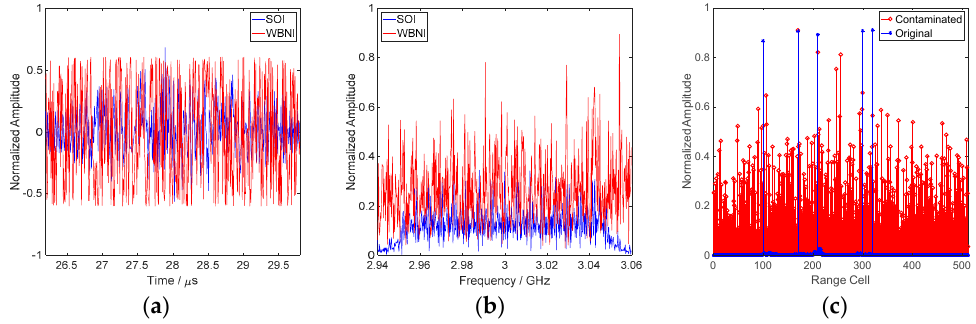
Figure 6. Signal characteristics. ( a ) Waveform; ( b ) frequency spectrum; and ( c ) range reconstruction.